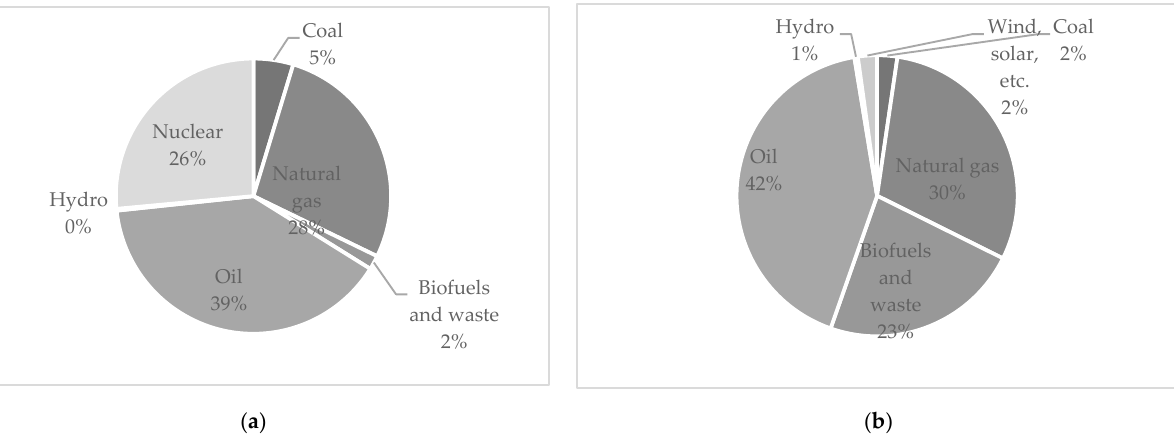
Figure 7. Structure of energy supply in Lithuania: ( a ) 1990; ( b ) 2020. Source: authors’ compilations based on database of the International Energy Agency.